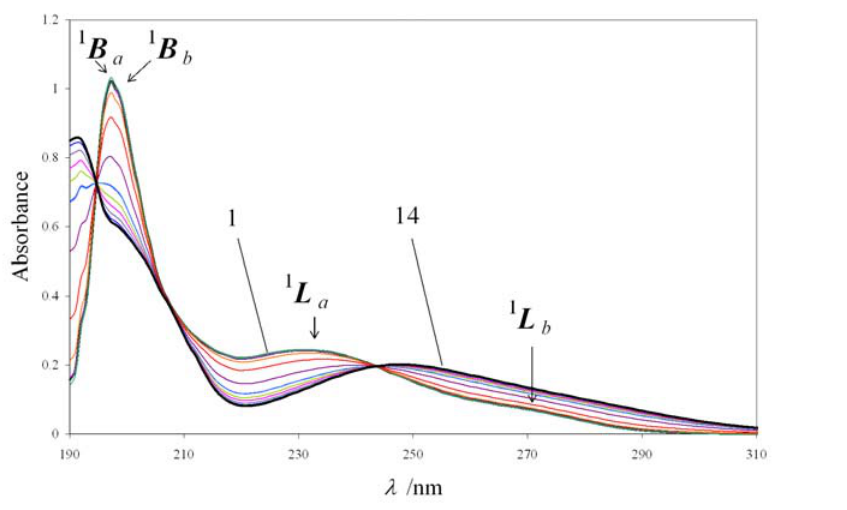
Fig. 2 Changes in the reconstructed absorption spectra of o -benzotoluidide as a function of sulfuric acid concentration from 0.5 (curve 1) to 15.0 mol dm − 3 (curve 14).